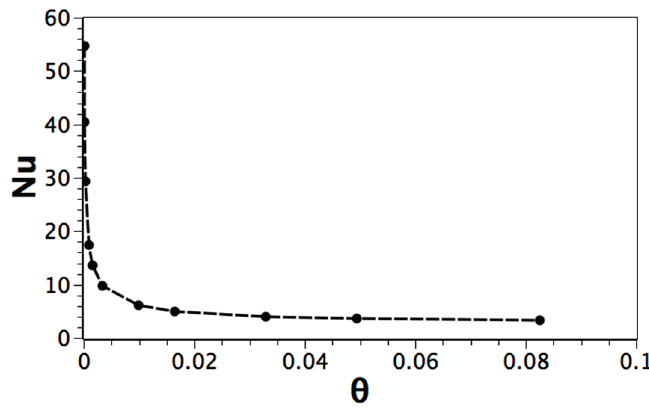
Figure 14. Entropy generation for melting with convection (problem in Figure 1b) for Pr 50 = and 5 Ra 10 = .